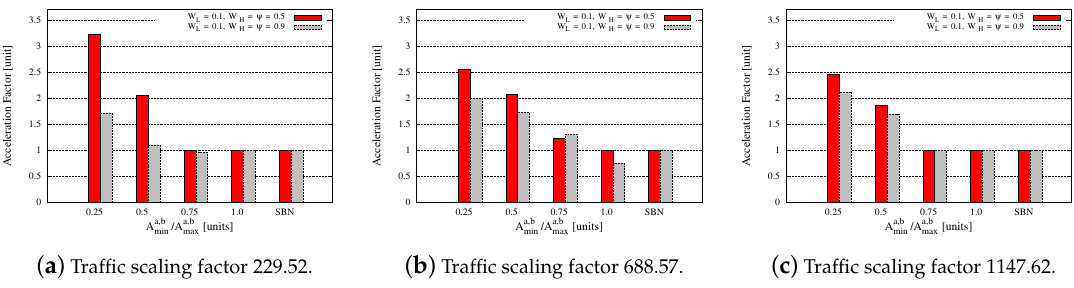
( a ) Traffic scaling factor 229.52. ( b ) Traffic scaling factor 688.57. ( c ) Traffic scaling factor 1147.62. Figure 3. Energy consumption E EWA